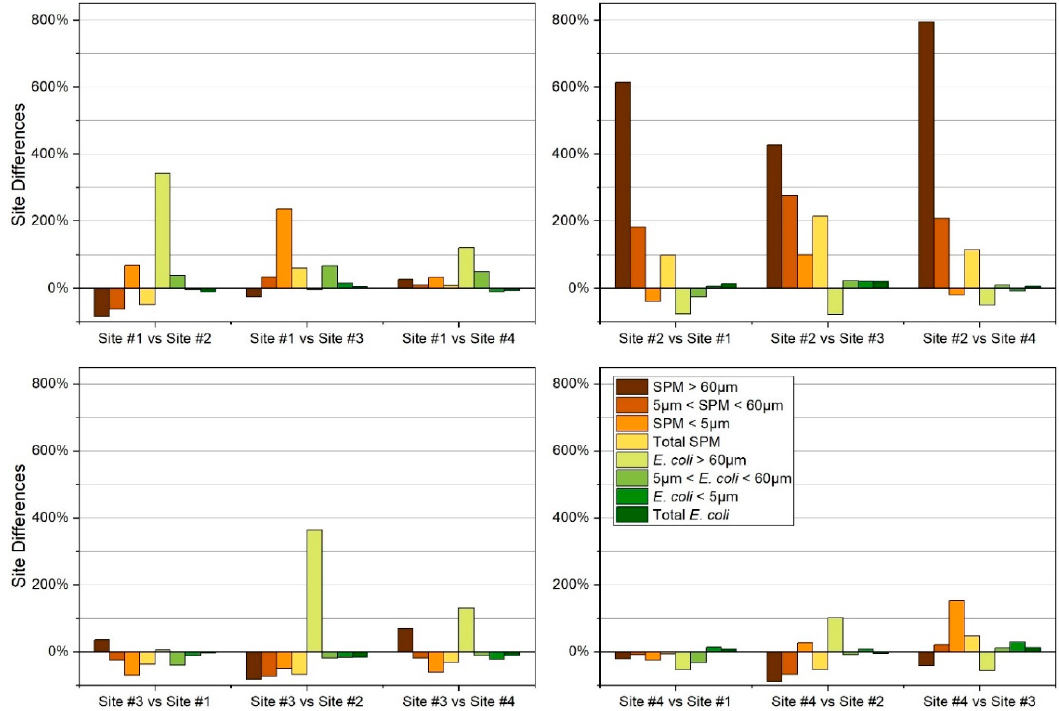
Figure 6. Suspended particulate matter (SPM) and E. coli concentration percent difference, separated into filtration intervals (<5 µm; 5 µm < interval < 60 µm; and >60); and total, at four monitoring sites during study period (20 July 2018–27 October 2018) in West Run Watershed, Morgantown, West Virginia, USA.